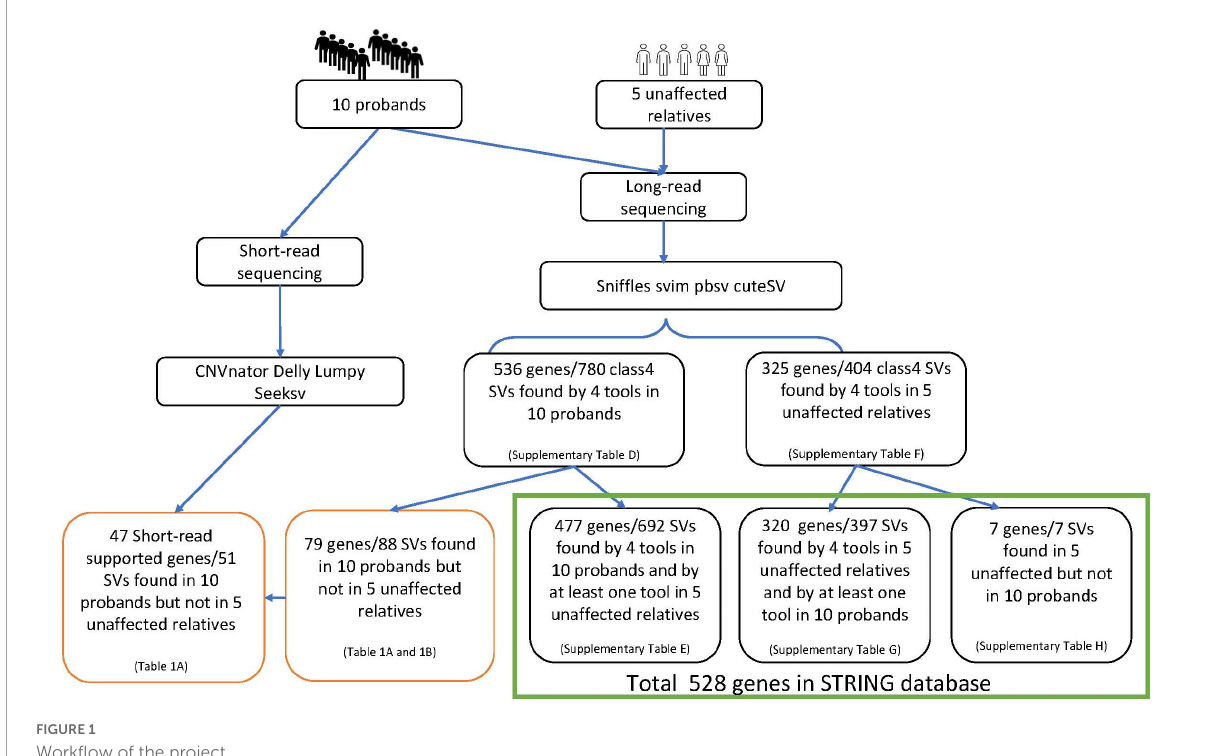
FIGURE1 Workflow of the